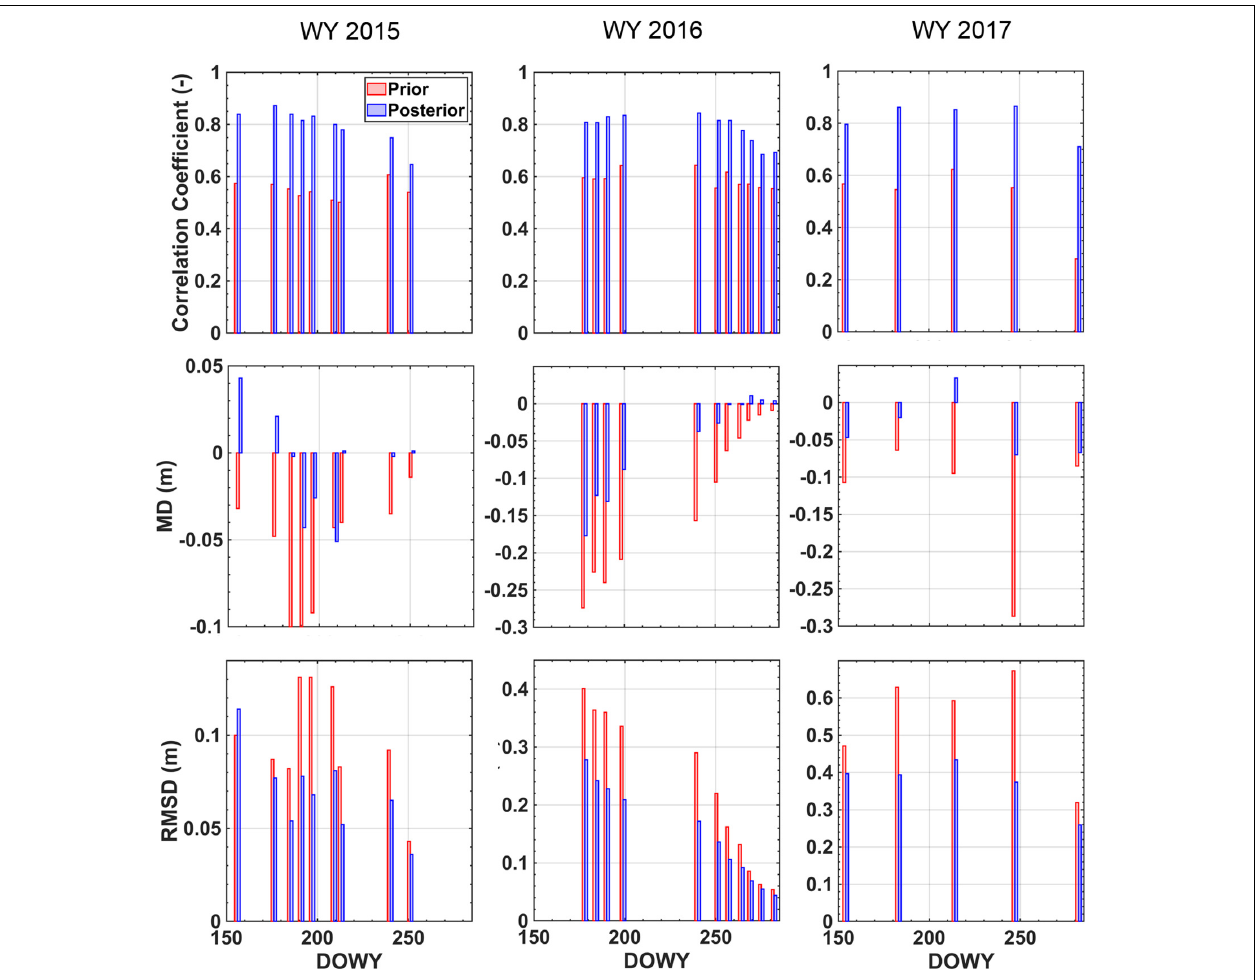
FIGURE 9 | Comparison of ASO SWE estimates to the prior and posterior SWE estimates for each WY (organized in columns) as characterized by the spatial pattern correlation (top row) , the mean difference (middle row) , and root-mean-squared difference (bottom row) . Result for the prior and posterior are shown in red and blue